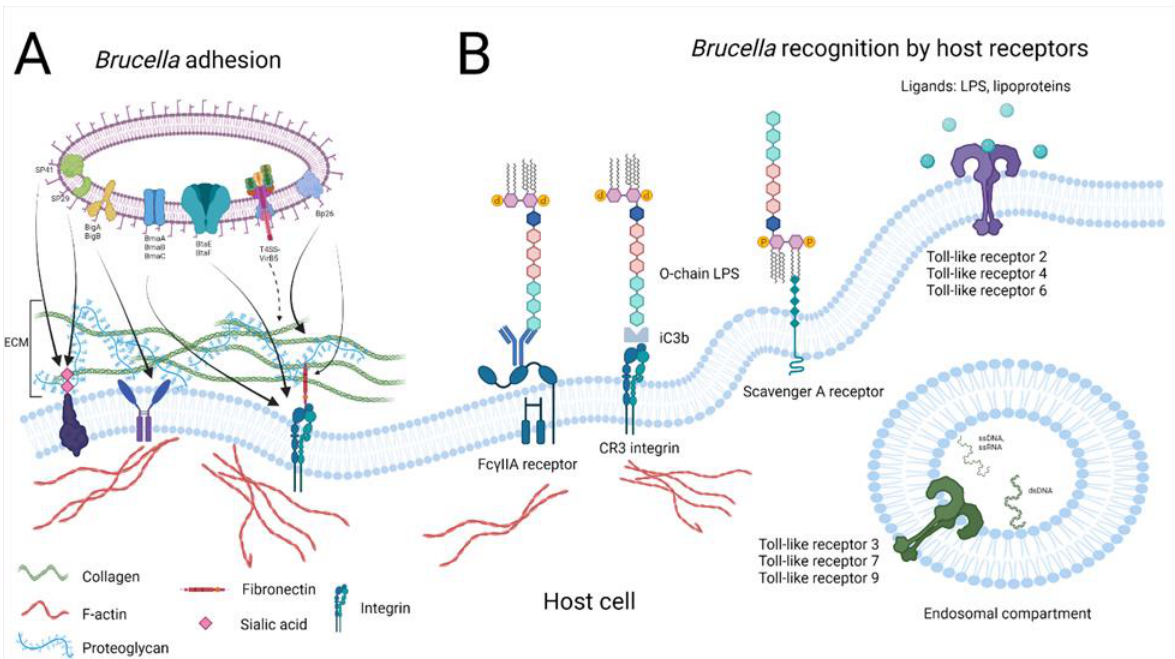
Figure 1. Brucella adhesion and recognition. ( A ) Brucella expresses various adhesins such as SP29, SP41, BigA, BigB, BmaA, BmaB, BmaC, BtaE, BtaF, Bp26, and T4SS-VirB5. These adhesins enable